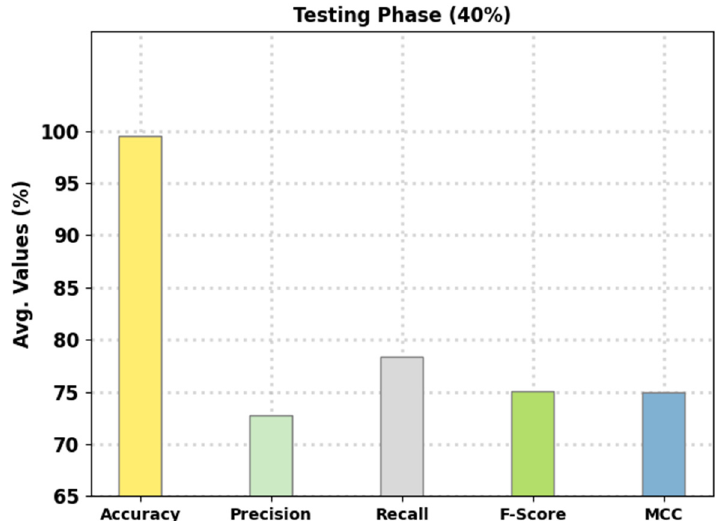
Figure 5. Average analysis of FSHDBN-CID approach under 40% of TS dataset.